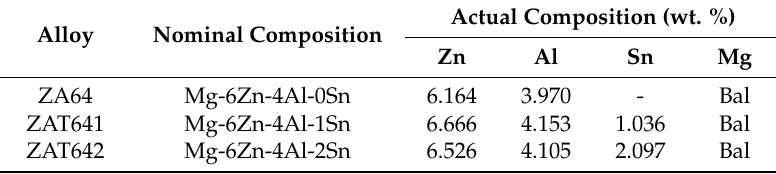
Table 1. Chemical compositions of the experimental alloys in weight percentage.